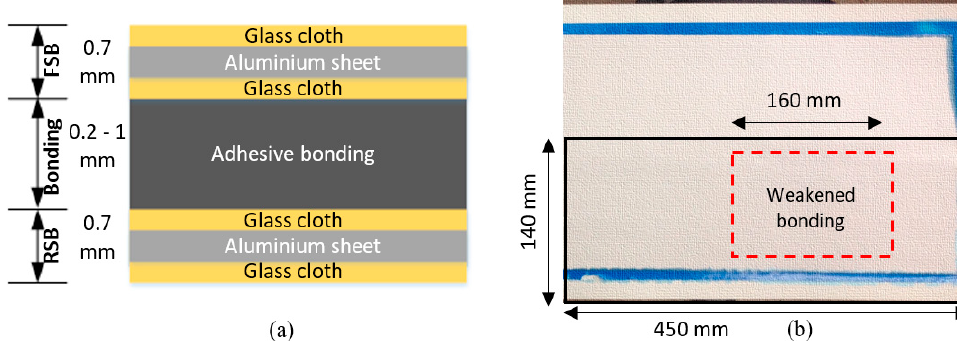
Figure 11. The schematic illustration of the adhesive bonded triplex layers: ( a ) the thickness layout of the adhesive bonded triplex layer; and ( b ) top view of the triplex specimen.